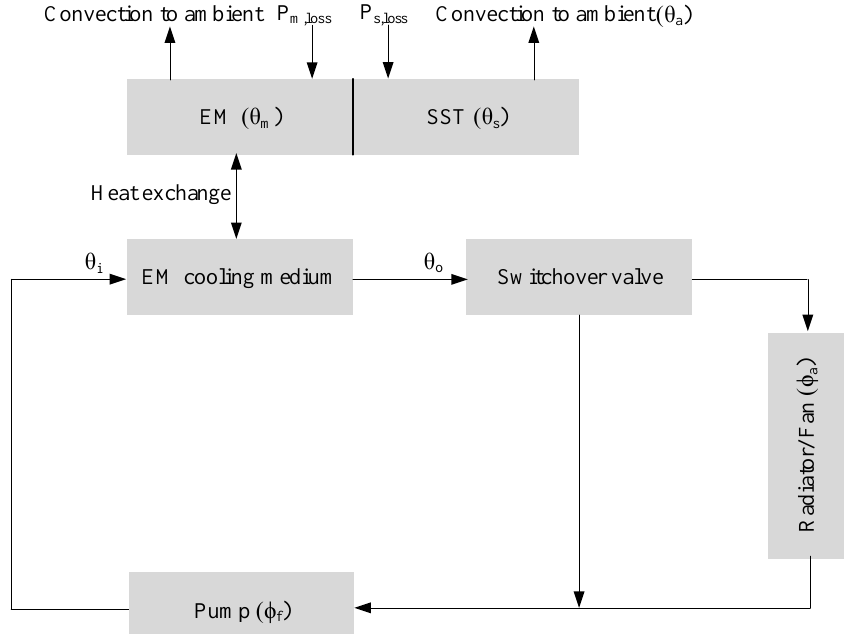
Figure A4. Thermal management architecture for the